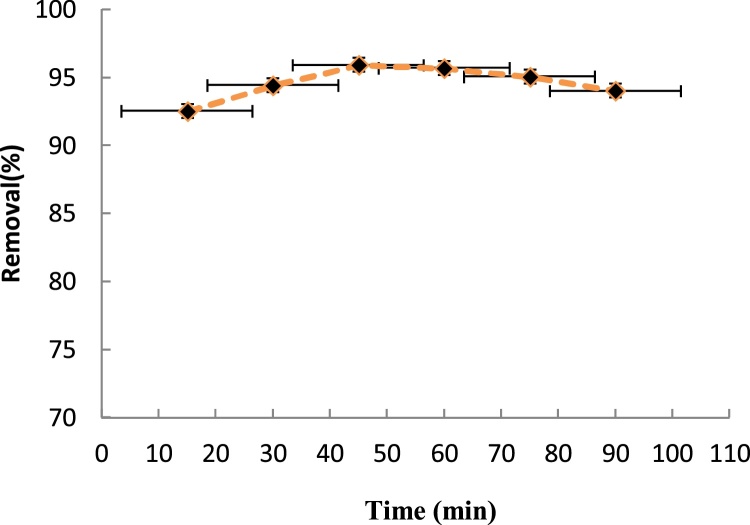
Effect of contact time on the removal efficiency of aniline (Aniline concentration: 20 mg/L, H2O2 concentration: 0.01 mol/L, pH: 3).